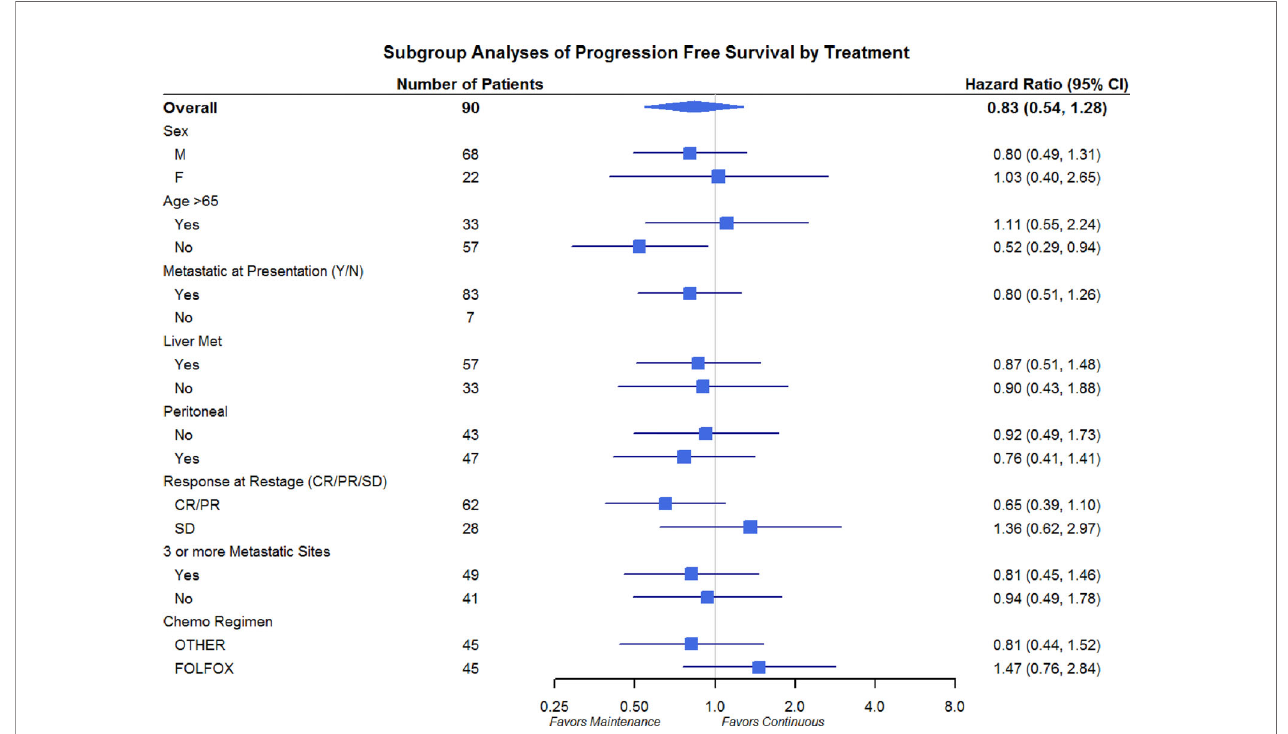
FIGURE 4 | Progression-Free Survival Subgroup Analysis of Gender, Age, Metastatic Site, and Chemo Regimen.